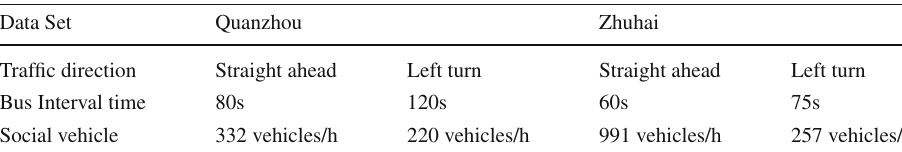
Table 1 Traffic flow data table